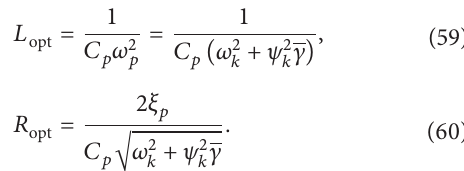
Figure 20: illustrating the performance as function of 𝜓 2 𝑘